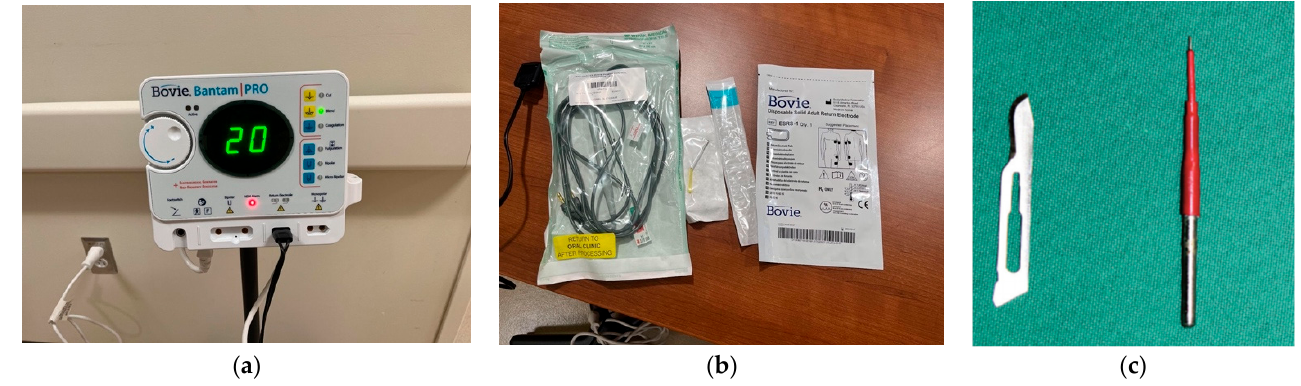
Figure 1. ( a ): A Bovie ESU set to 20 watts. ( b ): The wiring and electrosurgical tip for the Bovie. ( c ): A Colorado tip next to a #15 scalpel blade for size reference.